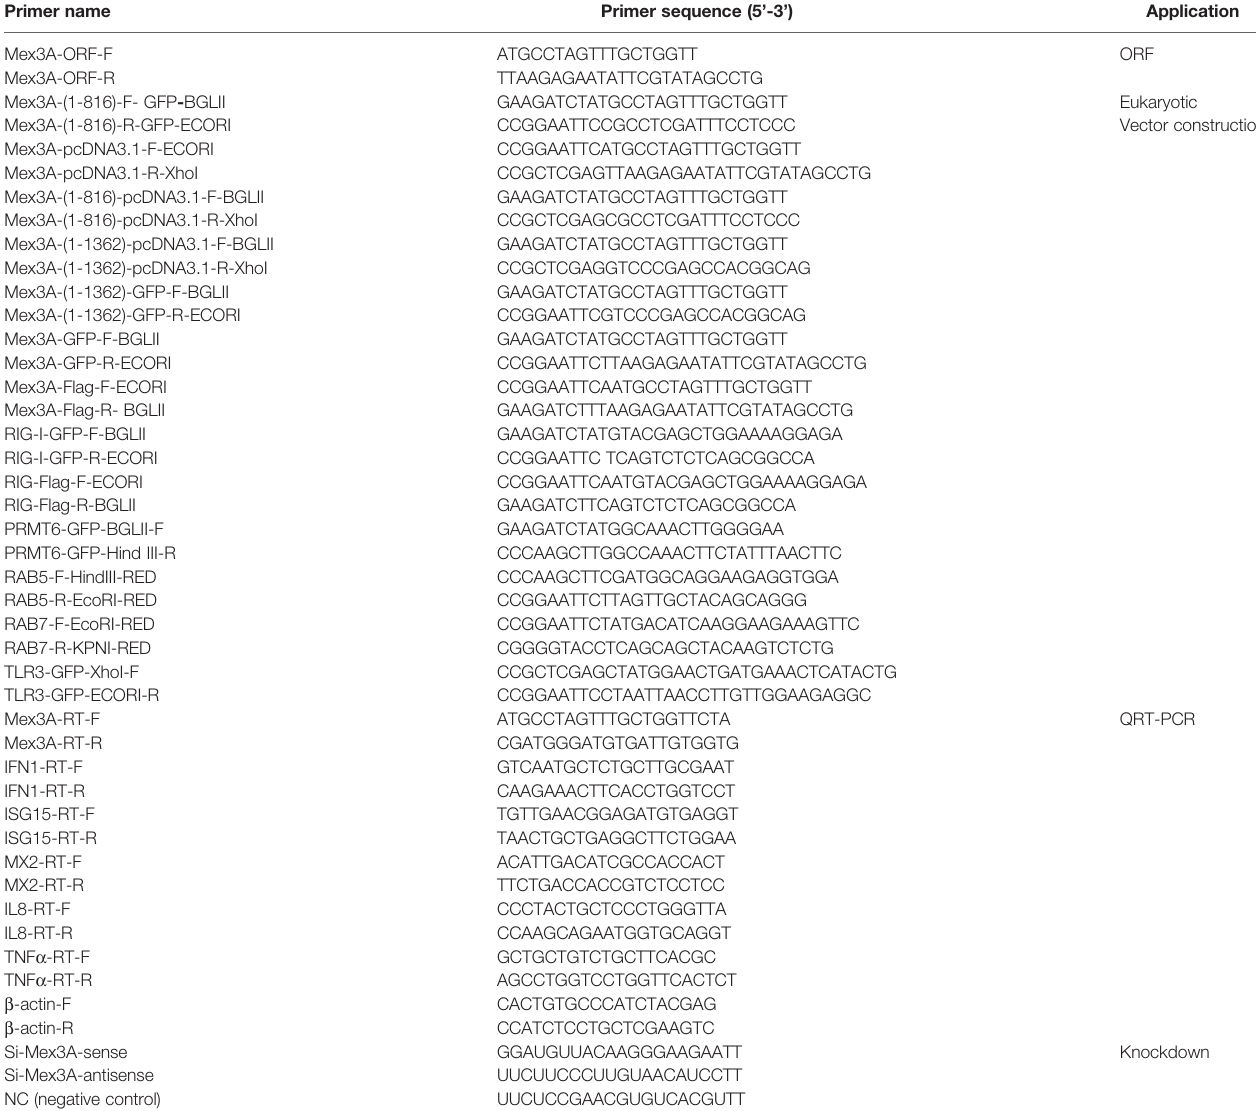
TABLE 1 | Sequences and application of primers and siRNA used in this